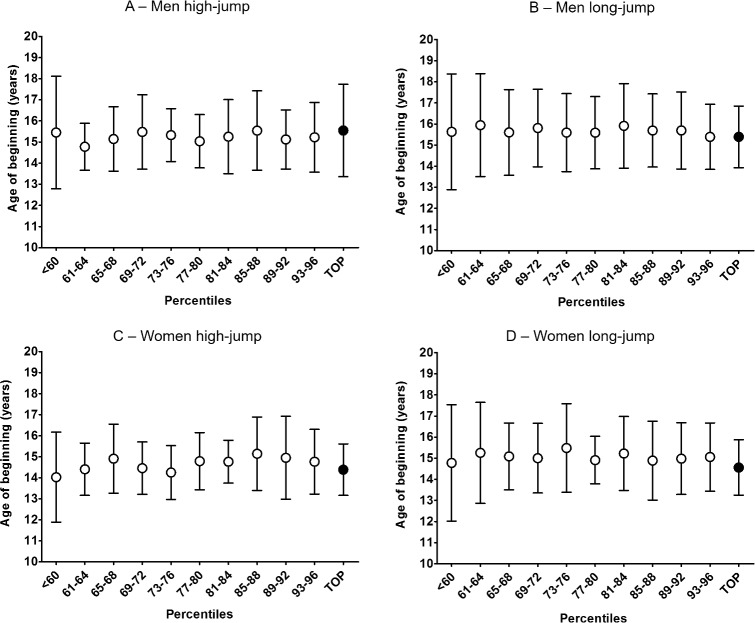
Age reaching personal best performance.The age of reaching personal best performance (mean±SD) is reported for each subgroup of athlete. The sample was sub-grouped on the base of the percentiles of the personal best performance (reported in the x axis). Overall, top-level athletes reached their personal best performance later than the rest of the sample in all disciplines and genders: (A) men high jump; (B) men long jump; (C) women high jump; (D) women long jump. Post hoc analysis is showed as: *** p<0.0001.